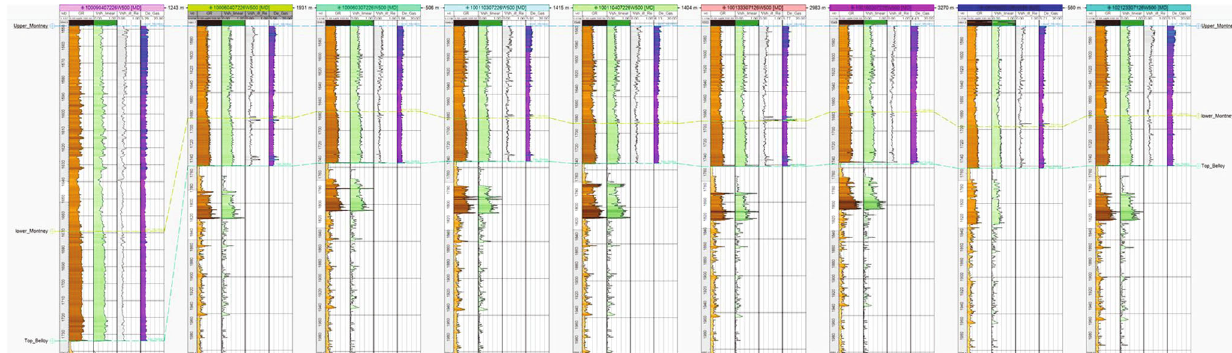
Figure 6: Well-log stratigraphy cross section displaying the upper and lower zone of Montney Formation and Belloy Formation of nine wells of eastern area (Table 1). Upper Montney Formation is fl attened. First column is gamma-ray log; second column is volume of shale droved from equation (1); third column is volume of illite mineral calculated from equation 6; fourth column is volume of desorbed gas drove from equation 7.